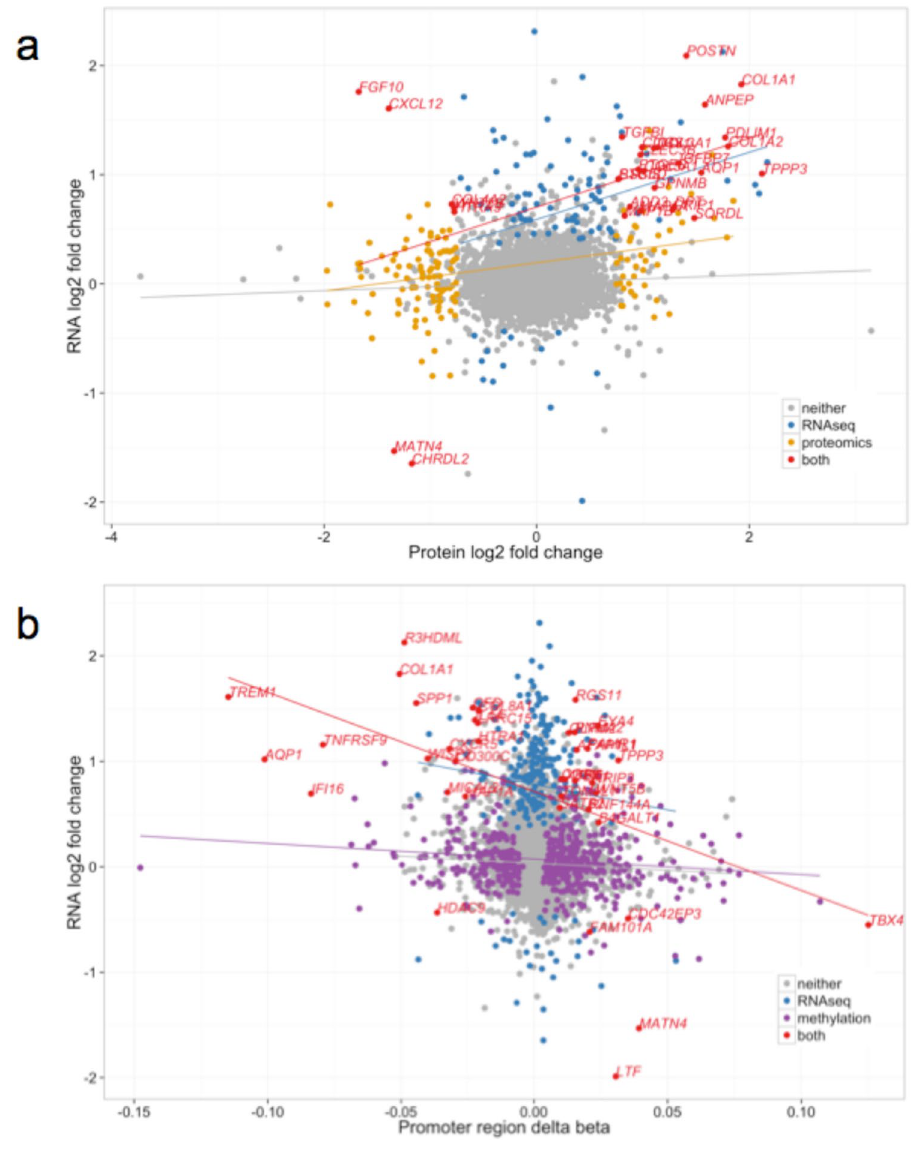
Figure 2. Comparison of changes identified in the –omics experiments. ( a ) Comparison of the log-fold- changes between all genes identified in both the proteomics and RNA-seq experiments. Each gene is represented as a single point, and the colour corresponds to whether the gene is identified as differentially expressed using edgeR in the RNA-seq or proteomics experiments, or both. The trend lines are derived from a linear regression in each subset. Positive fold changes indicate increased expression in degraded samples. ( b ) Comparison of RNA-seq log-fold-change and mean promoter region methylation change. The trend lines are derived from a linear regression in each subset. Genes are coloured according to the results of the RNA-seq and the promoter-region analyses analogously to Fig.